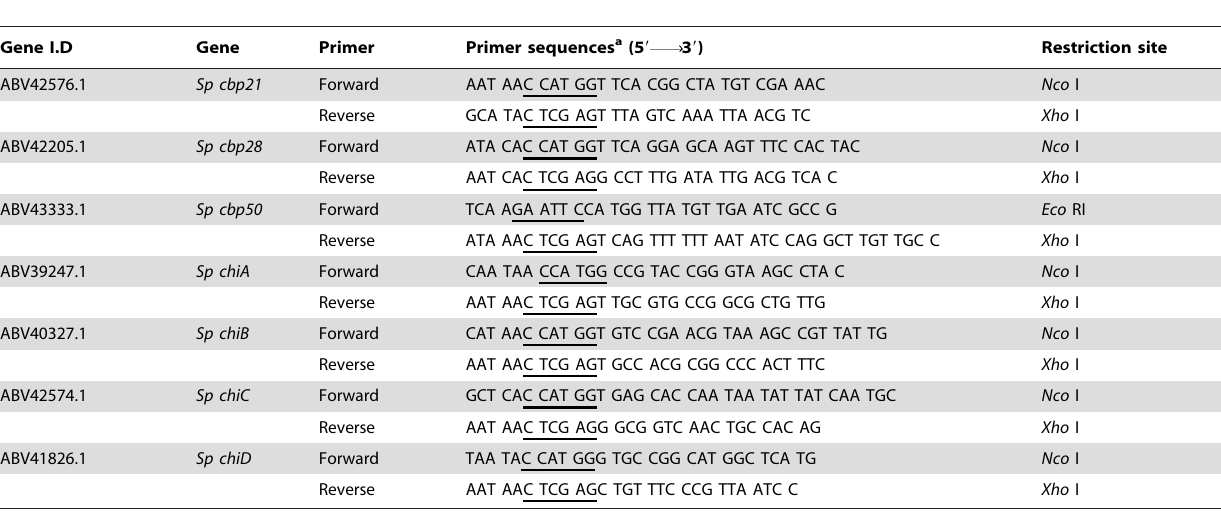
Table 2. List of primers used for the amplification of genes coding for chitin binding proteins and chitinases from Serratia proteamaculans